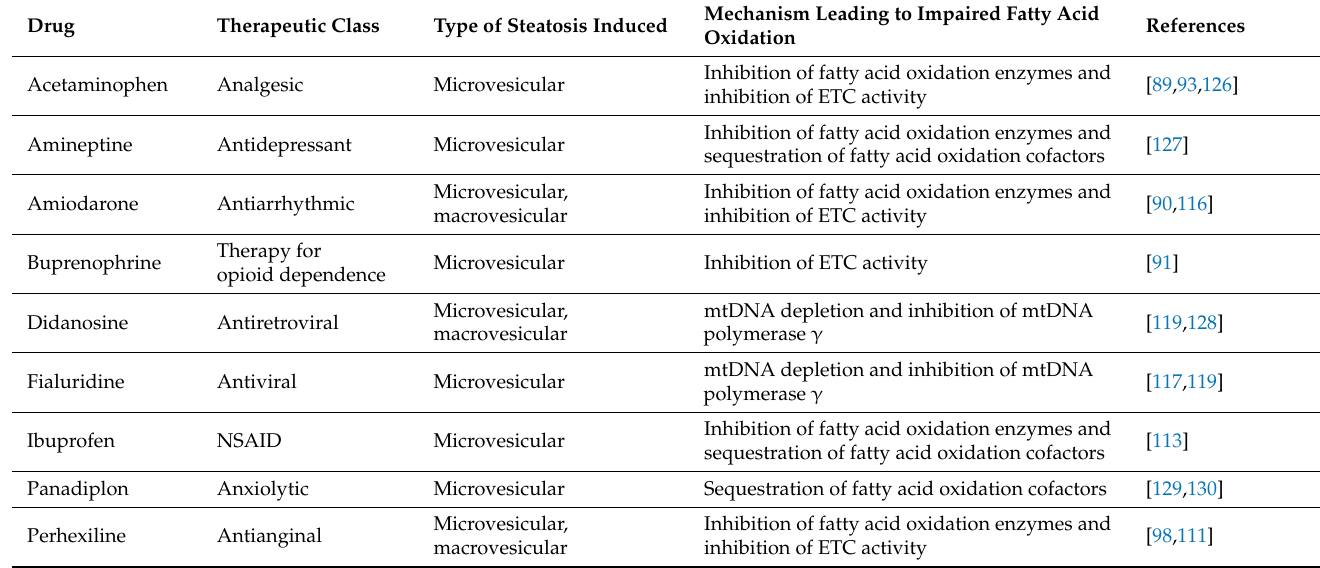
Table 3. DILI drugs reported to induce steatosis and fatty acid β -oxidation impairment. (DILI— drug-induced liver injury; ETC—electron transport chain; mtDNA—mitochondrial DNA; NSAID— nonsteroidal anti-inflammatory